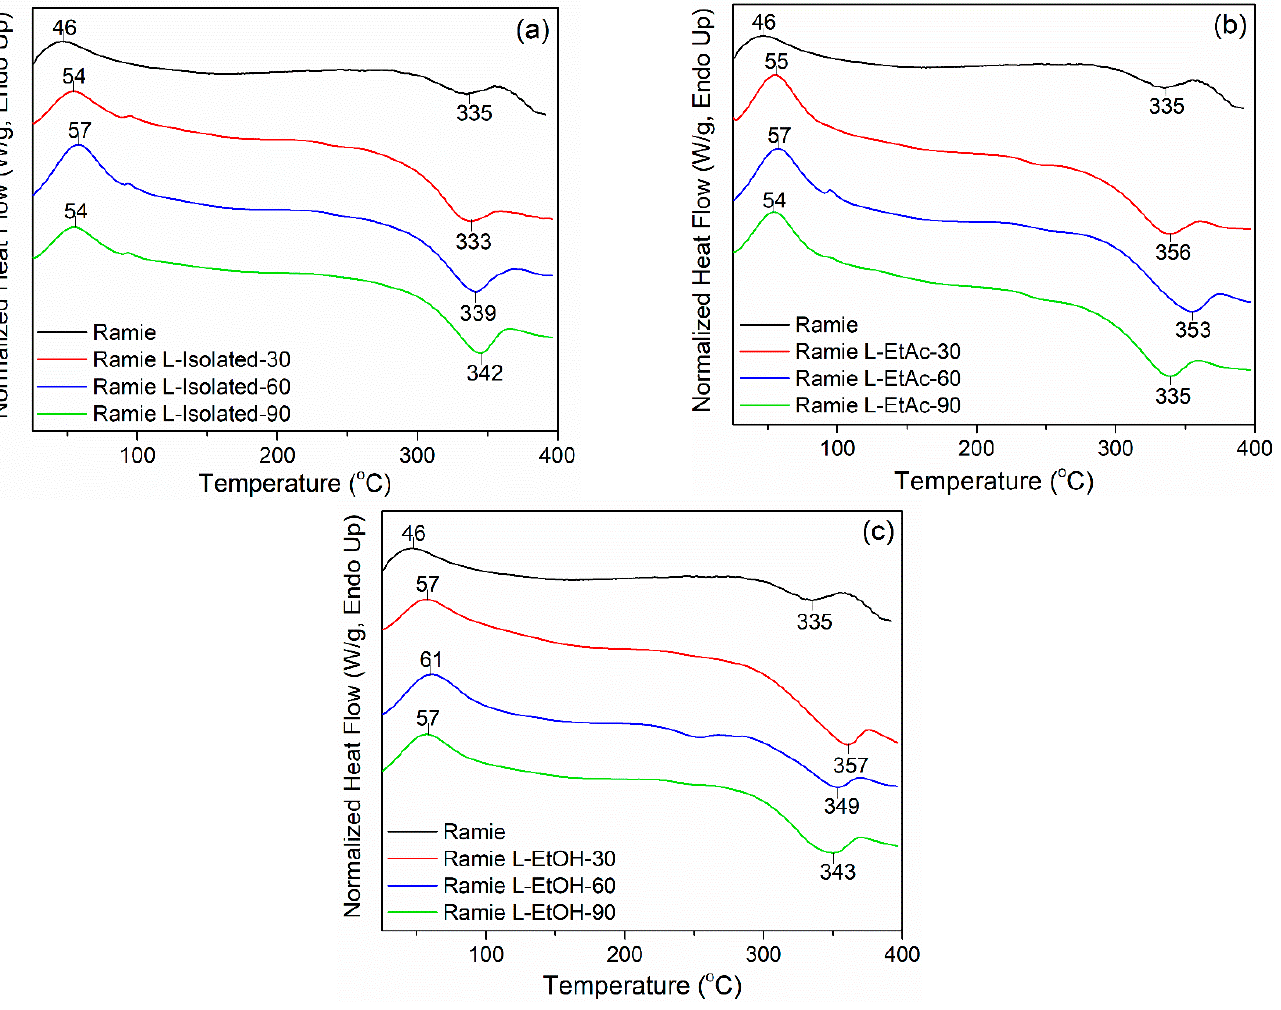
Figure 8. DSC analysis of before and after impregnated ramie fiber with lignin-based bio-PU: ( a ) ramie impregnated with L-Isolated, ( b ) ramie impregnated with L-EtAc, ( c ) ramie impregnated with L-EtOH.